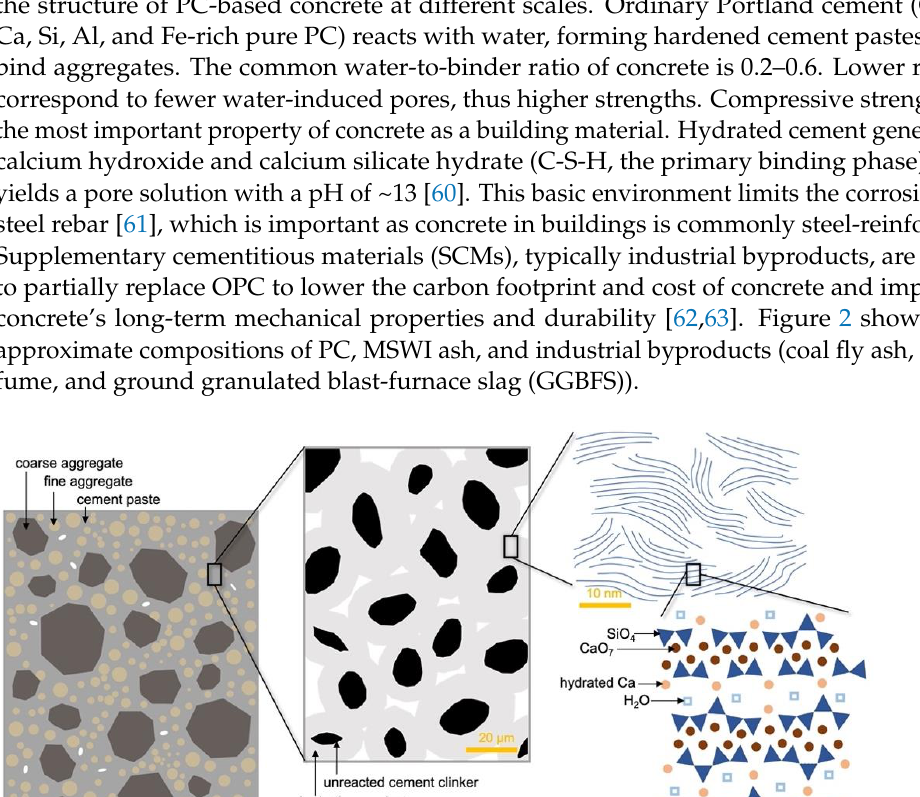
Figure 2. Approximate compositions of Portland cement, MSWI ash, and common industrial by- products as cement substitutes (coal fly ash, silica fume, and ground granulated blast-furnace slag (GGBFS)). Coal fly ash, silica fume, and GGBFS are byproducts from coal-fired power plants, sili- con/ferrosilicon manufacture, and crude iron production, respectively. C-S-H is a layered phase with a grain size of 3–5 nm [67,68]. C-S-H can adsorb many organics due to its high surface area [69,70] and immobilize many toxic elements (e.g., Cr, Pb, Sb, and Zn) by interlayer Ca substitution and surface complexation [71–73]. Minor hydration products, e.g., ettringite (Ca 6 Al 2 (SO 4 ) 3 (OH) 12 · 26H 2 O), can also immobilize toxic elements [74]. PC hydration products can also bind chlorides [75]. Cl in its inorganic form is non-toxic, but it destabilizes the passive film of steel rebar in reinforced concrete, result- ing in rebar corrosion [61]. Many other types of cement also yield ettringite or other hydration products that immobilize toxic elements. However, alternative cement (e.g., magnesium phosphate ce- ment [76–78] and calcium aluminate cement [79–81]) is expensive and has pitfalls in prac- tical applications (e.g., service temperature, setting time, and flowability). Non-PC-based alternative cement is merely a niche product with a market size incomparable to the vol- ume of MSWI ash and PC.